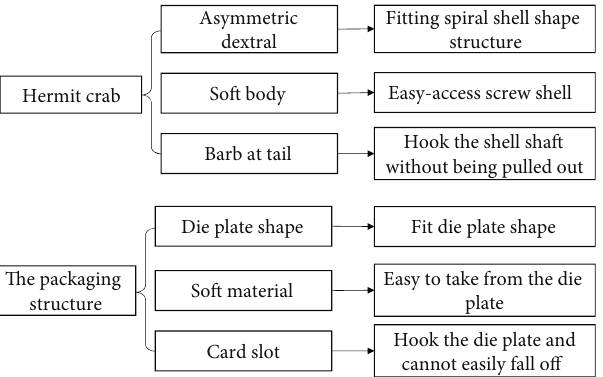
Figure 14: The schematic diagram of the biotechnology system transformation of the packaging plate structure.